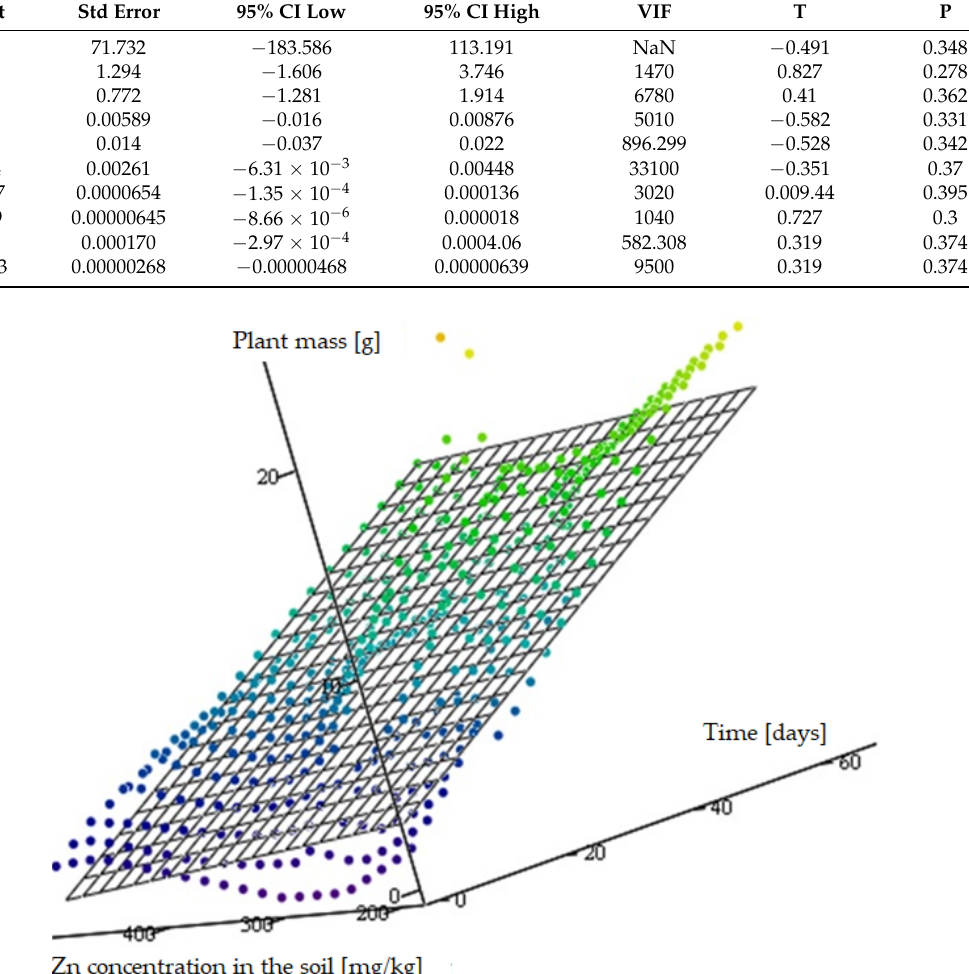
Figure 7. Variation of lettuce mass with time and the concentration of Zn in the soil, as a three- dimensional surface, corresponding to linear interpolation.